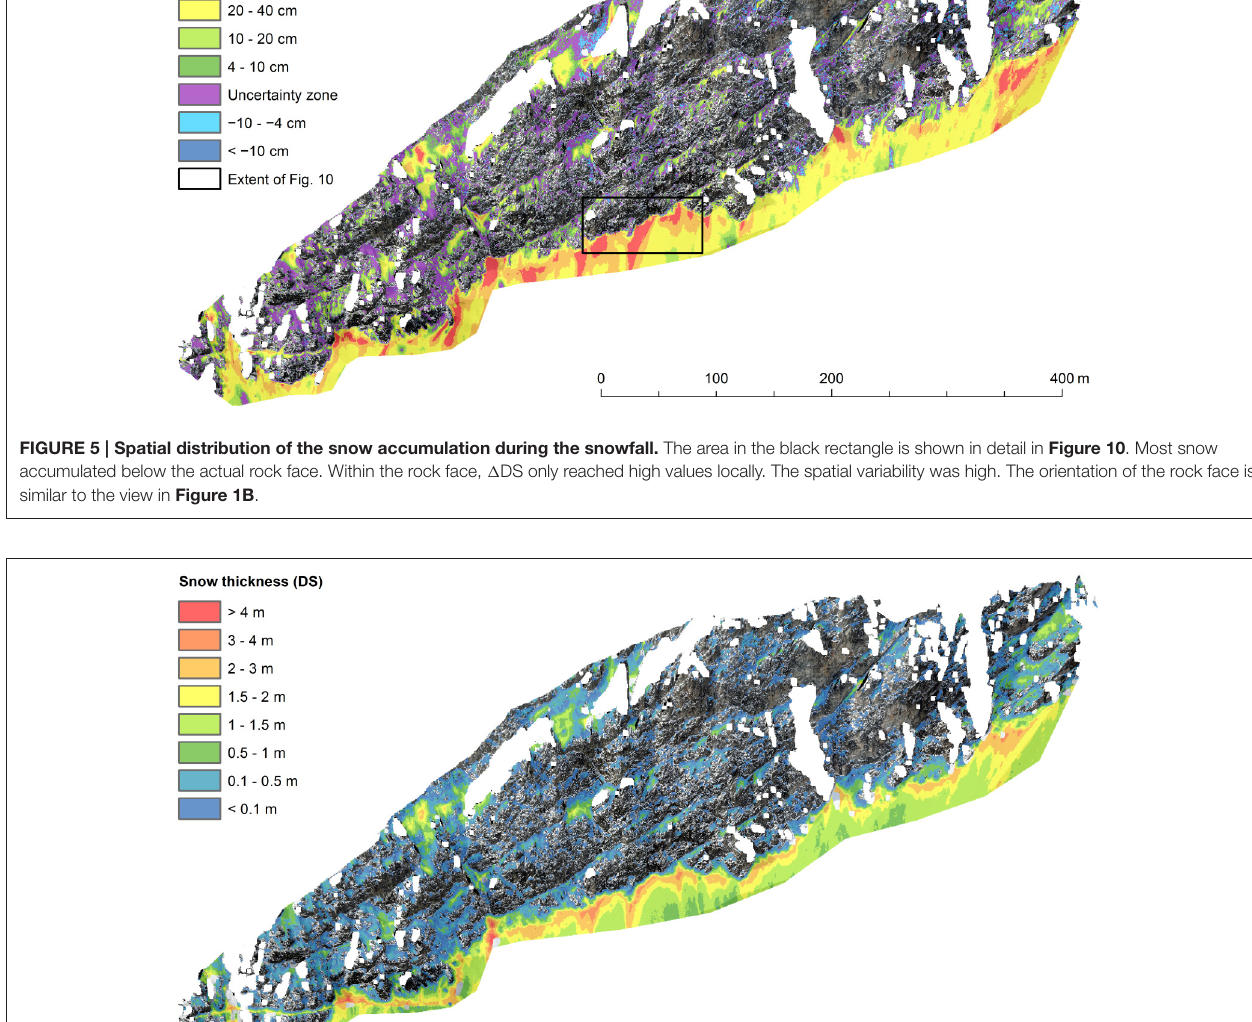
especially in snowfields adjacent to the ridge/crest. In other snowfields, 1 DS was predominantly negative and the variability was correspondingly high (see also Figure 4B ). Only little snow accumulated in the “steep/rough” areas. In fact, many cells have values within the uncertainty zone. The spatial patterns of the total snow thickness after the snowfall were similar to those of the snow thickness change ( Figure 6 ). The correlation coefficient between DS and 1 DS is r = 0.86. The similarity also becomes evident by comparing Figures 5 , 6 . As an example, the areas with DS > 2 m correspond very well to the areas with 1 DS > 60 cm. This